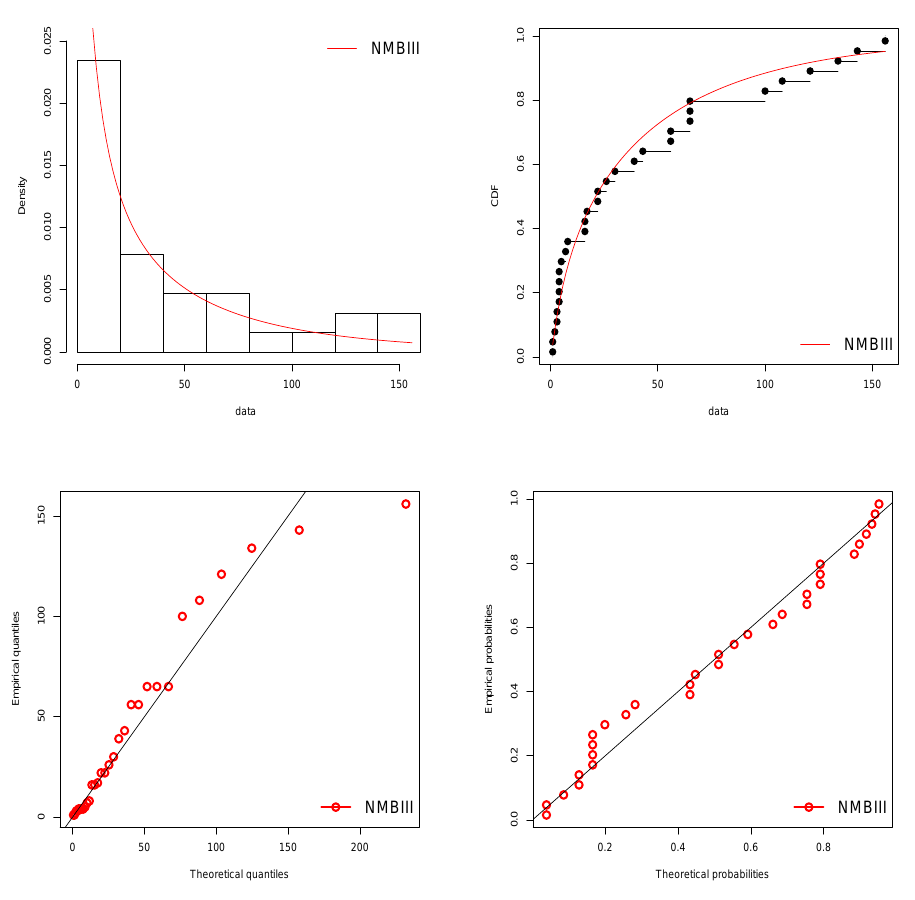
Figure 5. Estimated density ( top left ), cdf ( top right ), QQ-plot ( bottom left ), and PP-plot ( bottom right ) for data set